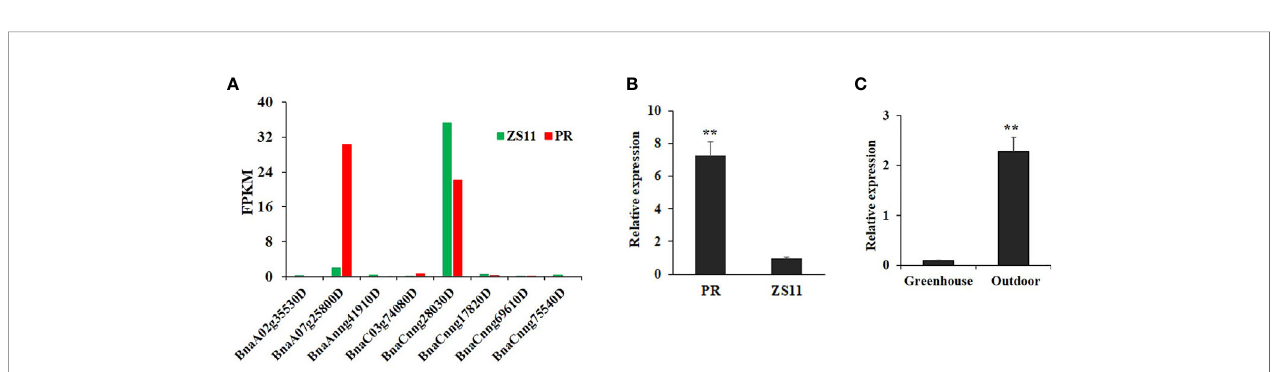
FIGURE 2 | Characterization of the expression of BnPAP2.A7 in purple and green rapeseed. (A) The fragments per kilobase of exon model per million mapped reads (FPKM) of eight AtPAP2 homologous genes in leaves of PR and ZS11. (B) qRT-PCR analysis of BnaPAP2.A7 in leaves of PR and ZS11 planted outside. (C) qRT-PCR analysis of BnaPAP2.A7 in leaves of PR planted outside and in glass greenhouse. **P < 0.01, one-way ANOVA test. Error bars represent the SD of three